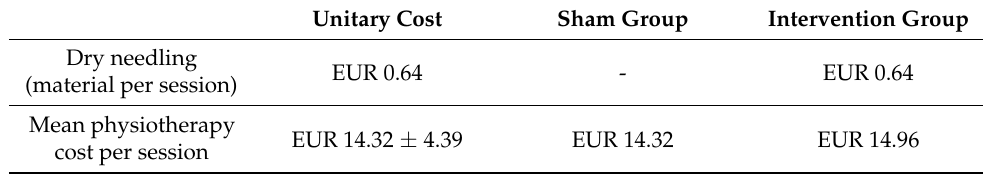
Table 1. Cost of